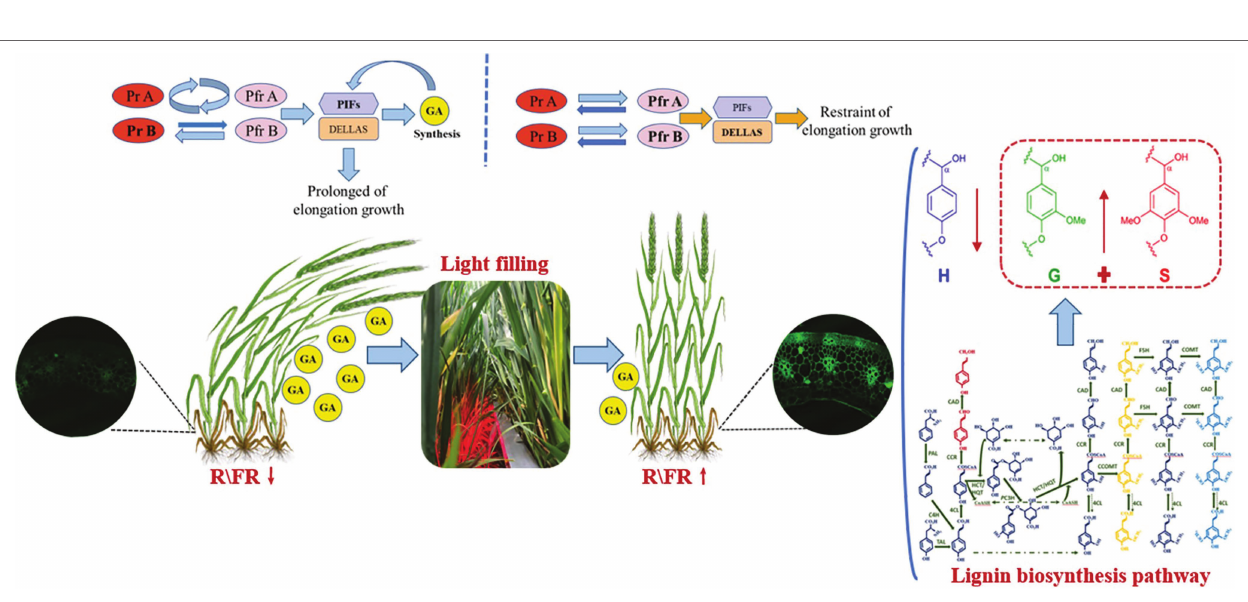
FIGURE 10 | Hypothetical mechanism of high R/FR promotion of lignin